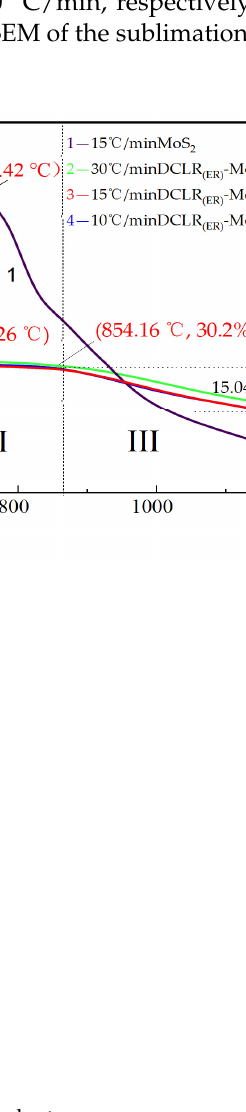
Figure 7. SEM image of the sublimation crystallization product. The pyrolysis characteristics of DCLR (ER) -MoS 2 -3 samples were significantly different from those of pure molybdenum disulfide, as shown in Figure 6, even though their curves varied at different heating rates. Pure MoS 2 samples began to lose weight gradually from the start of heating up to 527 °C, at which point they lost 14% of their weight, whereas DCLR (ER) -MoS 2 -3 began to react at 349 °C, with significant weight loss. This is the initial reaction stage. The first stage reached 606 °C at a heating rate of 10 °C/min and 15 °C/min, while the final stage reached 666 °C at a heating rate of 30 °C/min. As can be seen, various heating rates affect the reaction during the first stage. Temperatures of 10 °C/min, 15 °C/min, and 30 °C/min at 50% weight loss were 547 °C, 560 °C, and 596 °C, respectively, with the characteristics of 10 °C/min < 15 °C/min < 30 °C/min. The first stage temperatures of 10 °C/min and 15 °C/min overlapped at 606 °C. It was determined that the reaction at this stage was primarily the pyrolysis of DCLR (ER) and the oxidation of MoS 2 based on the reaction mechanism of DCLR (ER) -MoS 2 and pure MoS 2 . Unlike the first stage curve, TG curves with different heating rates almost overlapped until the reaction temperature reached 854 °C in the second stage. The weight loss in this region was less than 3.5%, indicating a stable stage primarily involving the diffusion of the product molybdenum trioxide. After 854 °C, the rate of thermal weight loss increased, reaching 15.04% between 854 °C and 1200 °C. When compared to the MoO 3 and DCLR (ER) -MoO 3 high-temperature reaction rules in Sections 2.2 and 2.3, it is clear that the sublimation reaction of MoO 3 , the oxidation product, takes place primarily in this region. In comparison to pure MoO 3 and DCLR (ER) -MoO 3 , the sublimation onset temperature of oxidation product MoO 3 in DCLR (ER) -MoS 2 increased by 113 °C and 107 °C, respectively. In the third stage, there was no significant difference in the weight-loss curves of different heating rates, as shown in Figure 4, and the weight-loss curves of 10 °C/min and 15 °C/min heating rates almost overlapped. The weight-loss rate was significantly greater at the two heating rates than at 30 °C/min at the same temperature. The slower heating rate increased the diffusion of molybdenum trioxide in the first stage, which is favorable for molybdenum trioxide sub- limation. Therefore, 15 °C/min was chosen as the best reaction heating rate in this experi- ment, taking reaction time into account, to achieve a higher product yield. The results are shown in Table 2.